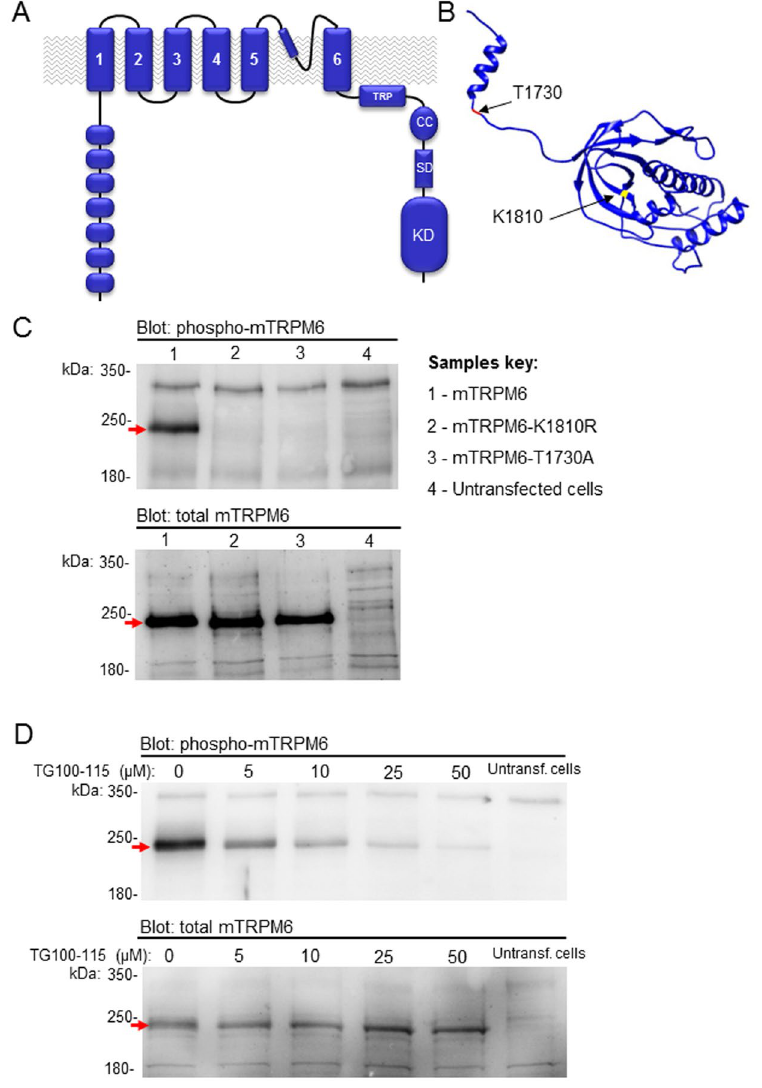
Figure 1. Domain topology of the cloned murine kinase-coupled channel TRPM6. ( A ) The plasma membrane channel segment of mTRPM6 comprises six transmembrane helices ( 1–6 ). A short stretch between the 5th and 6th helices contains a predicted pore forming loop and a pore helix. A N-terminus of mTRPM6 contains a set of predicted ankyrin-like repeats 1 . The mTRPM6 C-terminus contains a highly conserved transient receptor potential ( TRP ) domain, a coiled-coil ( CC ) domain, a kinase substrate domain ( SD ) and a kinase domain ( KD ). ( B ) 3D model of the mTRPM6 kinase domain generated as described previously 1 using annotated coordinates of the mouse TRPM7 kinase (PDB code 1IA9 46 ). K1810 is a highly conserved residue located in the catalytic site of the kinase domain. T1730 is a residue subjected to autophosphorylation by the mTRPM6 kinase. ( C ) Representative Western blot analysis of mTRPM6 variants using the anti-(p)T1730 mTRPM6 antibody ( upper panel) followed by stripping and re-probing of total mTRPM6 expression levels by anti-mTRPM6 polyclonal ab47017 antibody ( lower panel). The experiment was repeated three times with similar results. ( D ) Effect of TG100–115 on the autophosphorylation of mTRPM6. HEK 293 cells were transiently transfected with mTRPM6. 24 h after transfection, the indicated concentrations of TG100–115 were added to the cell culture medium and cells were cultured for additional 12 h and immunoreactivity of mTRPM6 was probed as in ( C ). A representative Western blot is shown. The experiment was repeated two times with similar